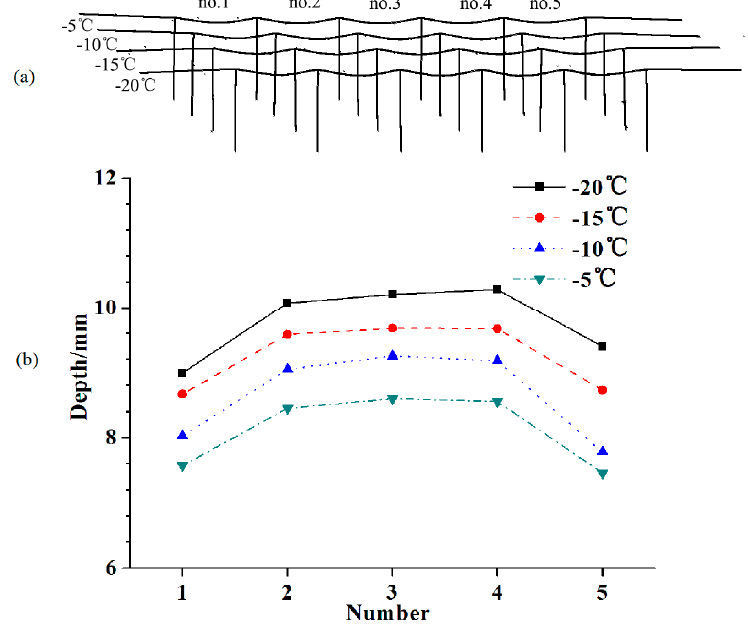
Figure 25. Deformation and maximum depth at different temperatures. ( a ) Deformation of the middle sections of the plate frame. ( b ) Maximum depth measured in simulation.